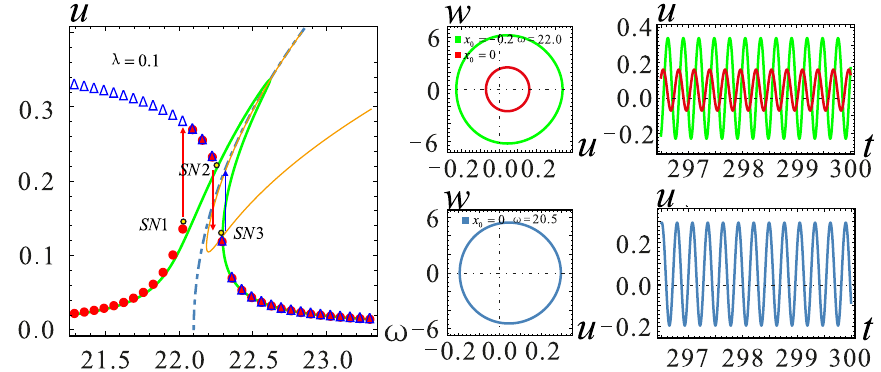
Figure 10. Phase diagram and the corresponding time history curve at λ = 0.1. The solid lines represent stable solutions. The dashed lines represent unstable solutions. The point represents the numerical solution.